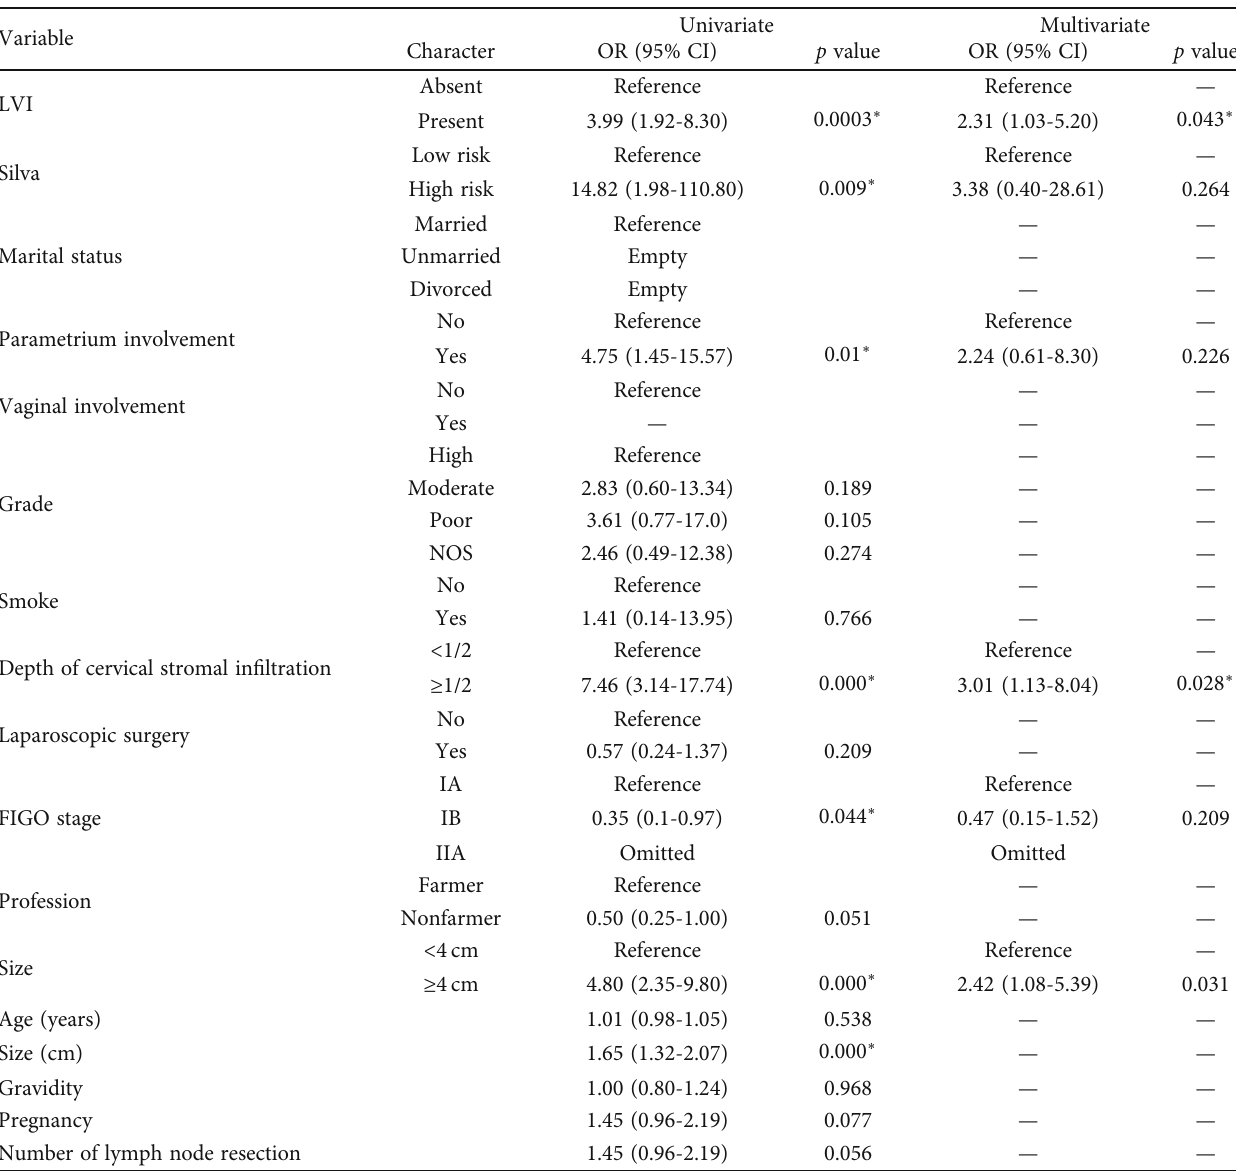
Table 2: Univariate and multivariate logistic regression analyses of